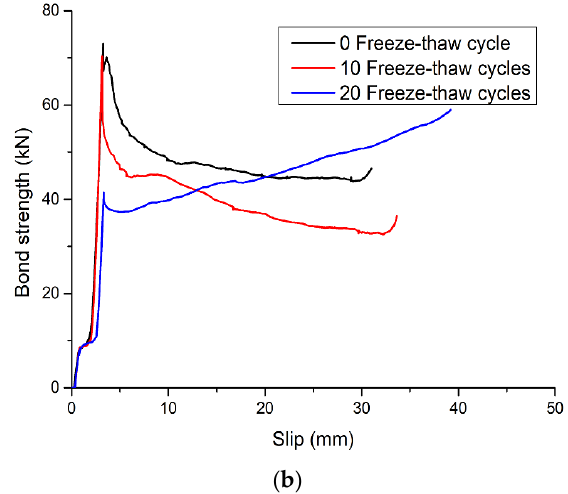
Figure 11. Load–slip curve of square steel tube push-out specimen: ( a ) C30; ( b ) C45 (the data in the figures are averaged).